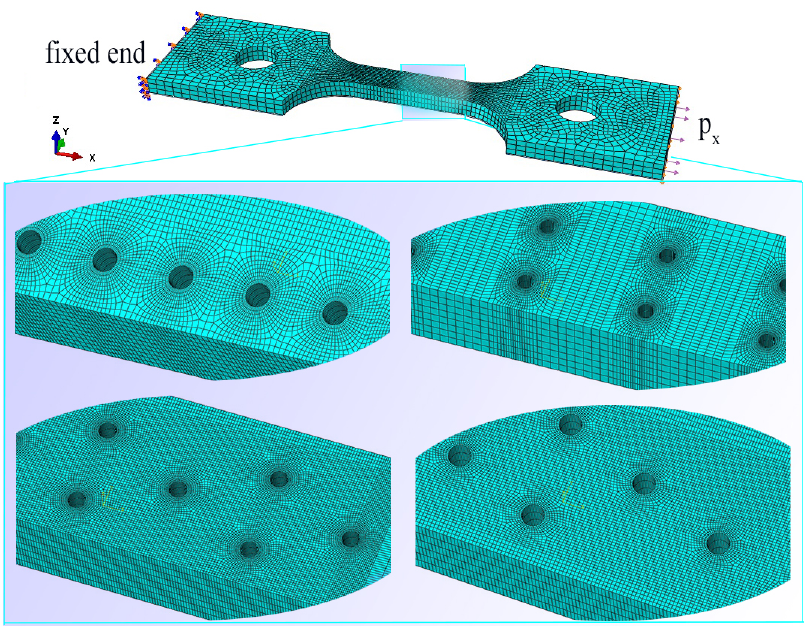
Figure 4. Finite element models of different types of